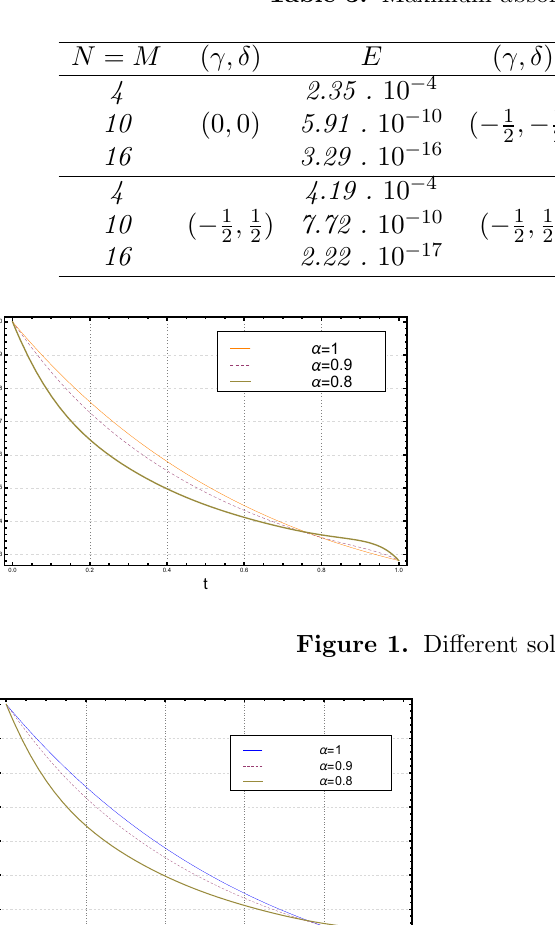
Table 3. Maximum absolute error of Example 5.